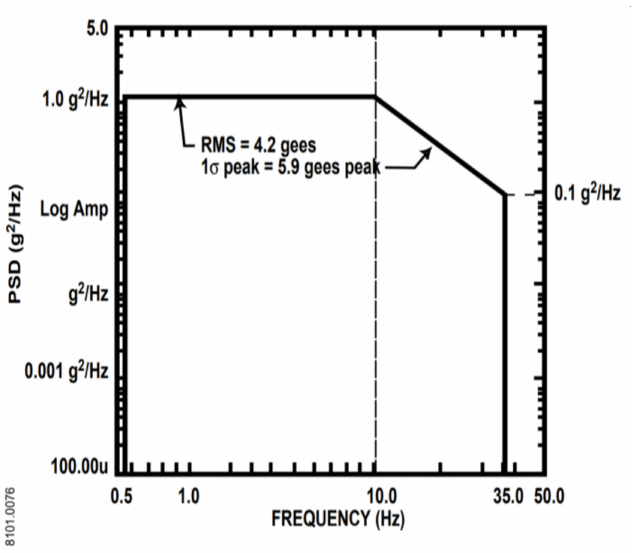
Figure 27. Requirements for vibration spectrum for flywheel at the rear end of a bus, adapted from